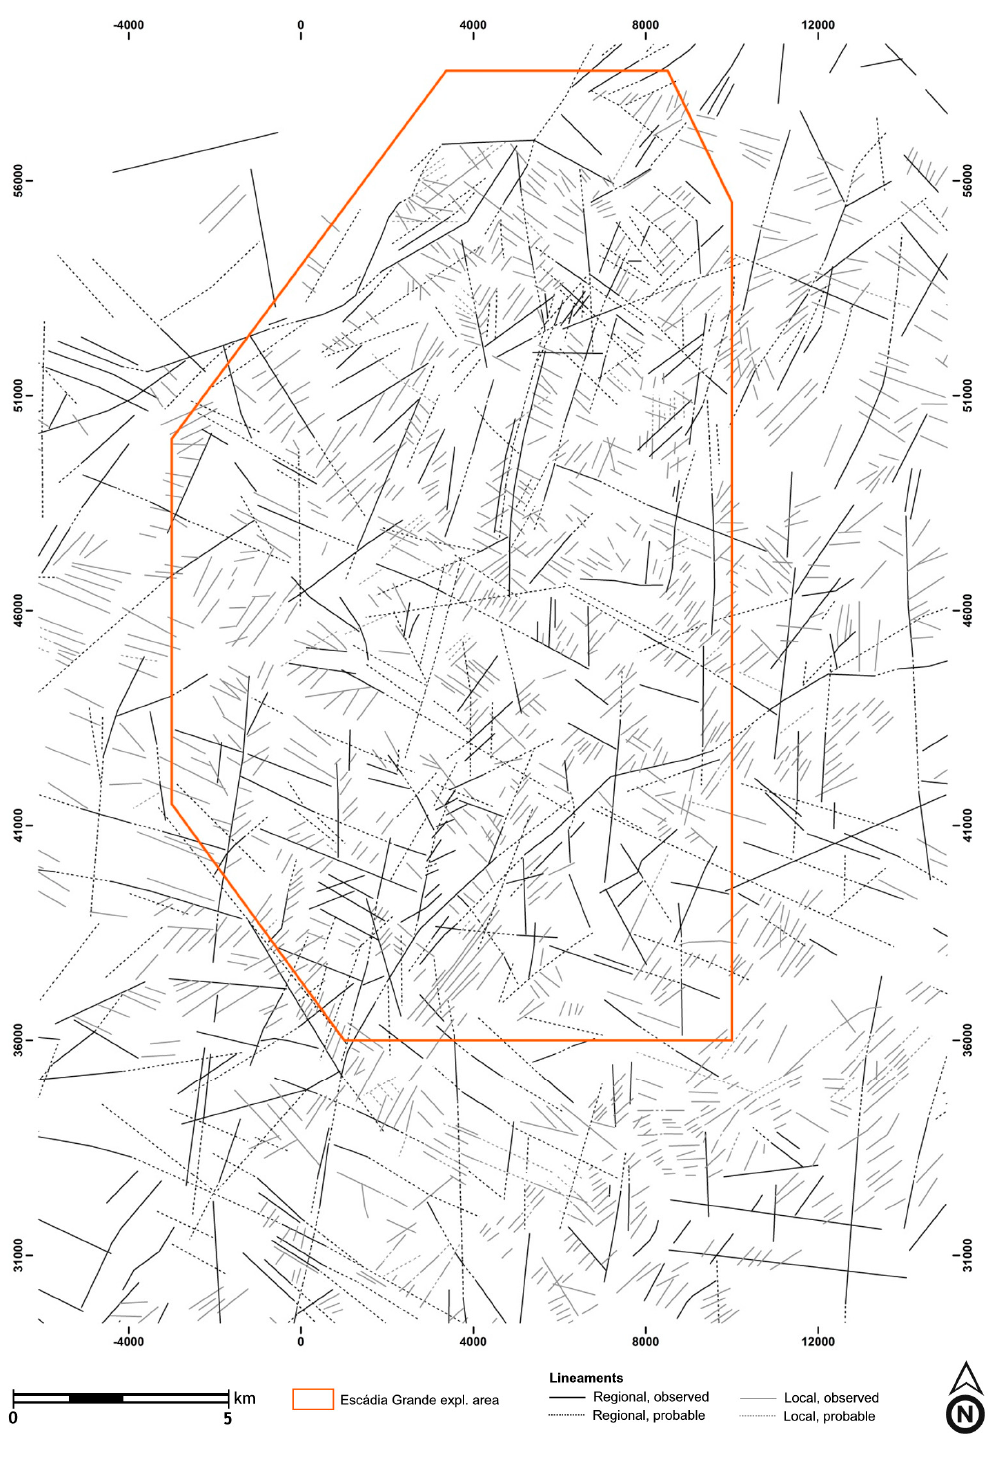
Figure 13. Final lineament map.